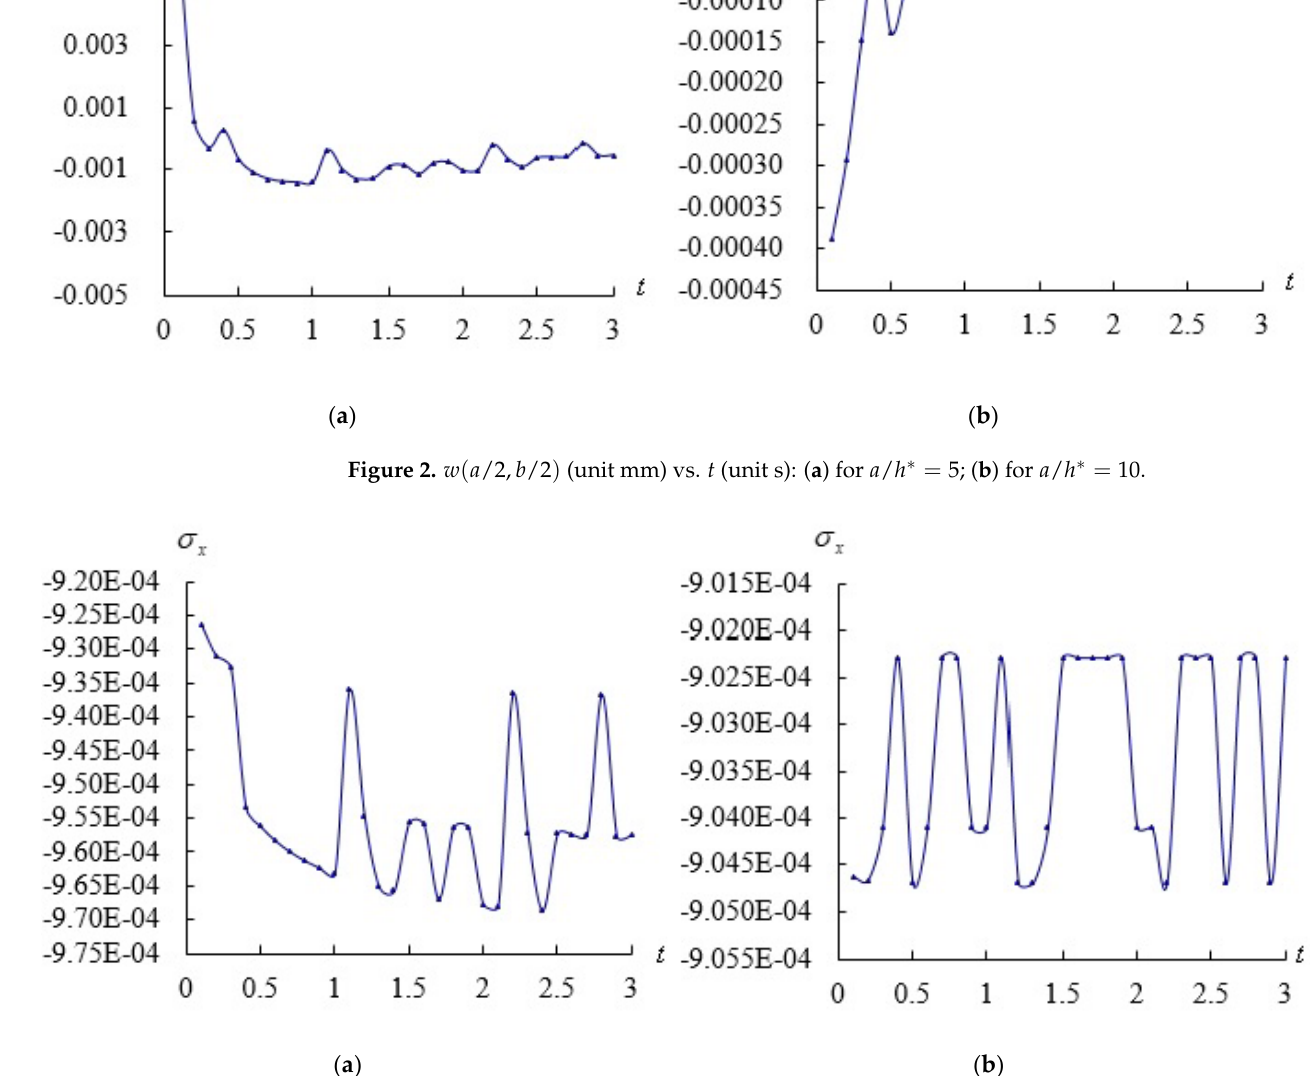
σ (unit GPa) vs. t (unit s): ( a ) for Figure 3. Stress σ x (unit GPa) vs. t (unit s): ( a ) a / h ∗ = 5; ( b ) for a / h ∗ = 10. Figure 3. Stress x Figure 5 shows the dominated stresses σ x (unit GPa) vs. T (unit K) and R n at center position of z = − 0.5 h ∗ for a / h ∗ = 5. The values of σ x for R n = 0.1 and 0.2 can proceed in higher T = 1000 K of temperature condition. The absolute value of maximum σ x is − 1.001130 × 10 − 3 GPa found at T = 1000 K for R n = 0.5 and